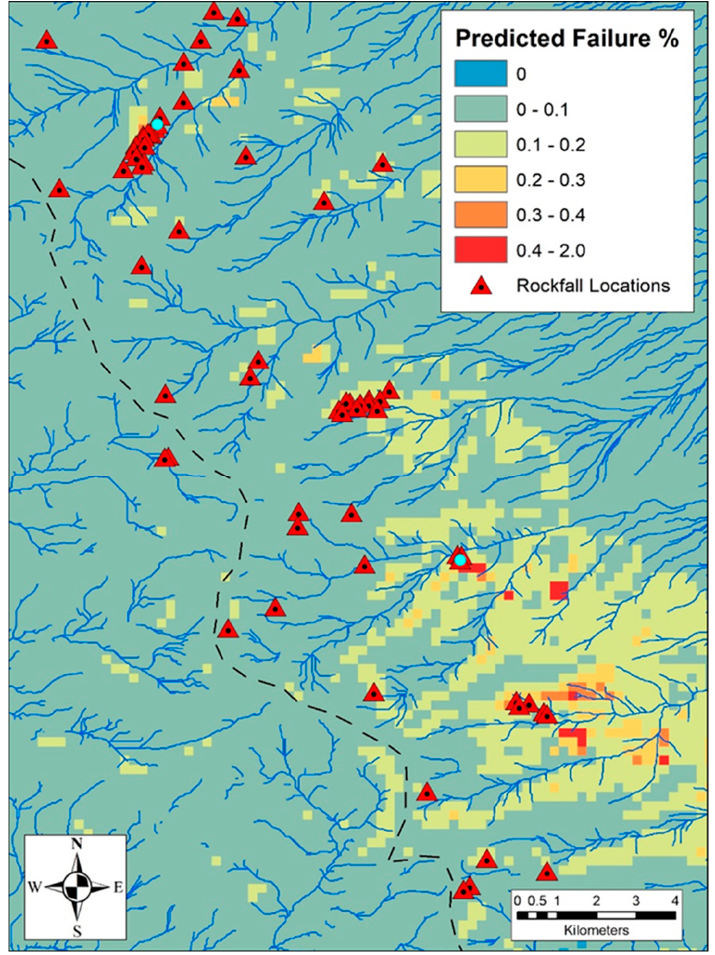
Figure 16. ShakeMap results for the Owens Lake earthquake HS study area. Predicted slope failure percentage computed using the model from [51]. Lower central blue dot corresponds to the Whitney Portal failure shown in Figure 13, while the upper right blue dot corresponds to the Williamson Creek failure shown in Figure 17. The main Sierra Nevada crest is shown with black dashed